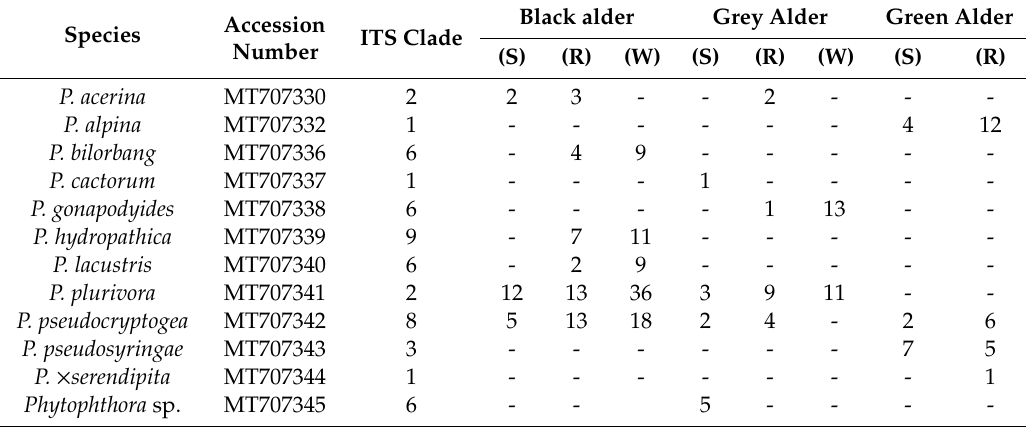
Table 3. Number of isolates of Phytophthora species obtained from stem ( S ), rhizosphere ( R ) and water ( W ) samples in the investigated